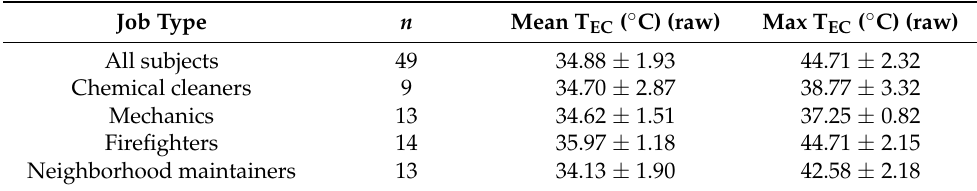
Table A1. Ear canal temperature, micro-climate temperature and relative humidity of all subjects and per job measured. Mean and max ear canal temperature (T EC ) ( ◦ C), nearby micro-climate temperature (T cli ) ( ◦ C) and relative humidity (RH) (%) of all subjects and per job measured with Cosinuss ◦ (raw) and ambient conditions chest box.